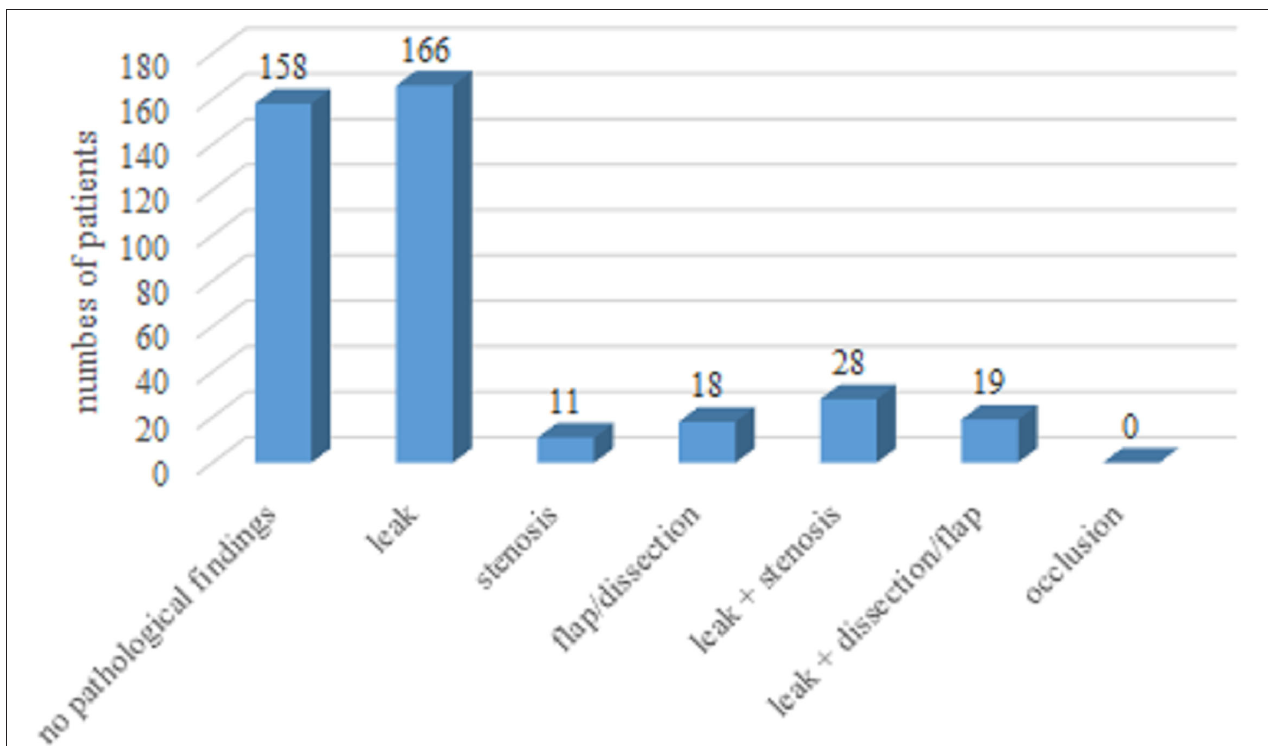
FIGURE 4 | Results of the angiogram of the access site after use of the closure device.